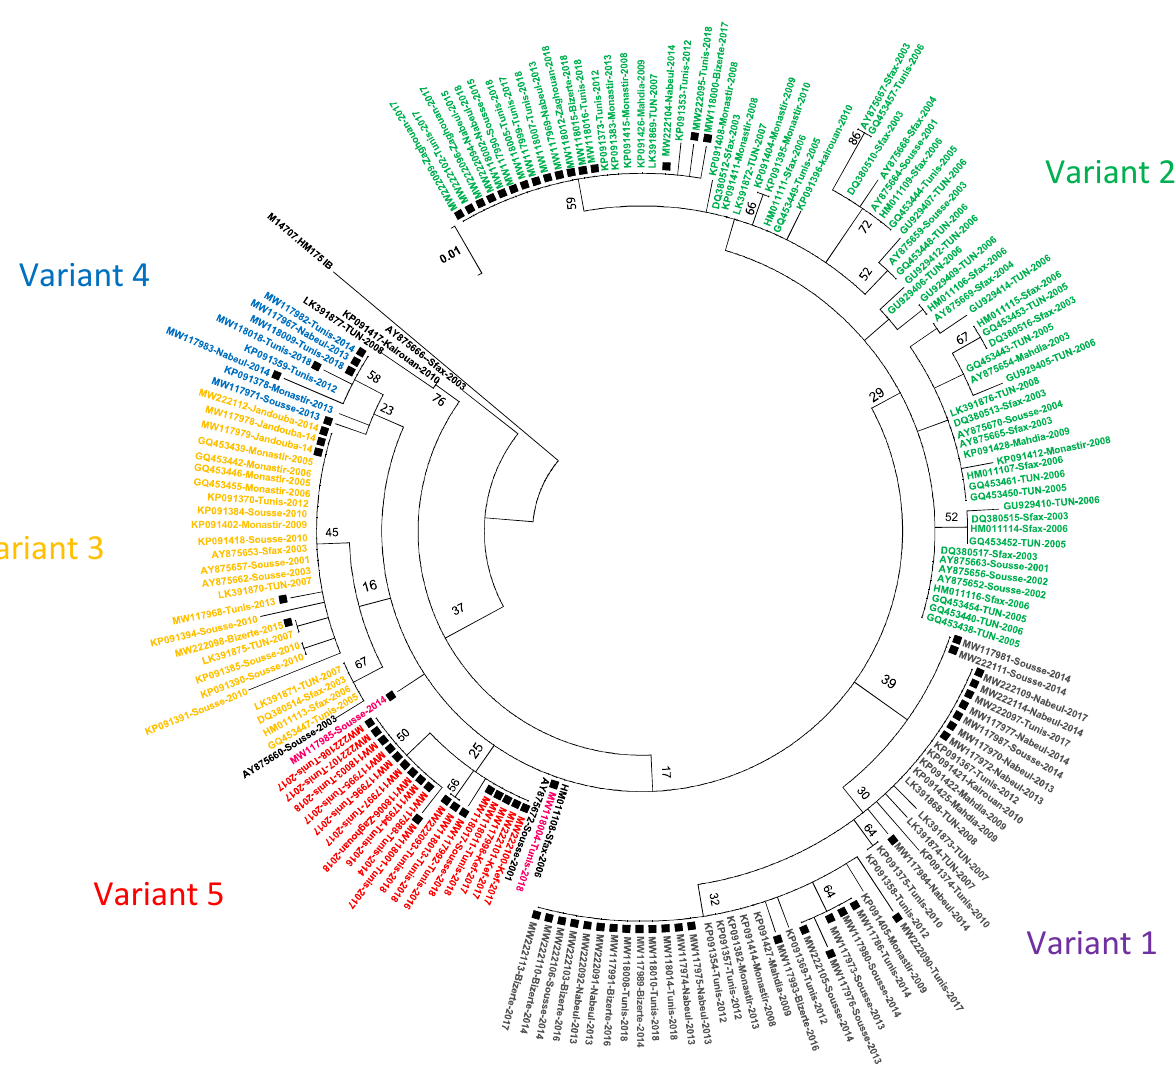
Figure 2. Phylogenetic tree of Tunisian HAV genotype IA isolates, constructed using the maximum likelihood method and the kimura-2 parameter model based on 168nt of the VP1-2A junction. Black squares represent isolates reported in this study (accession numbers MW117967 to MW118018 and MW222090 to MW222114). The sequences of isolates are indicated by their accession number followed by district and year of isolation. Sequences of unknown districts are indicated by their accession number followed by the country code and the year of isolation. Genetic variants are represented in different colors. Topology was supported by 1000 bootstrap replicates. Reference strain HM175 was used as an